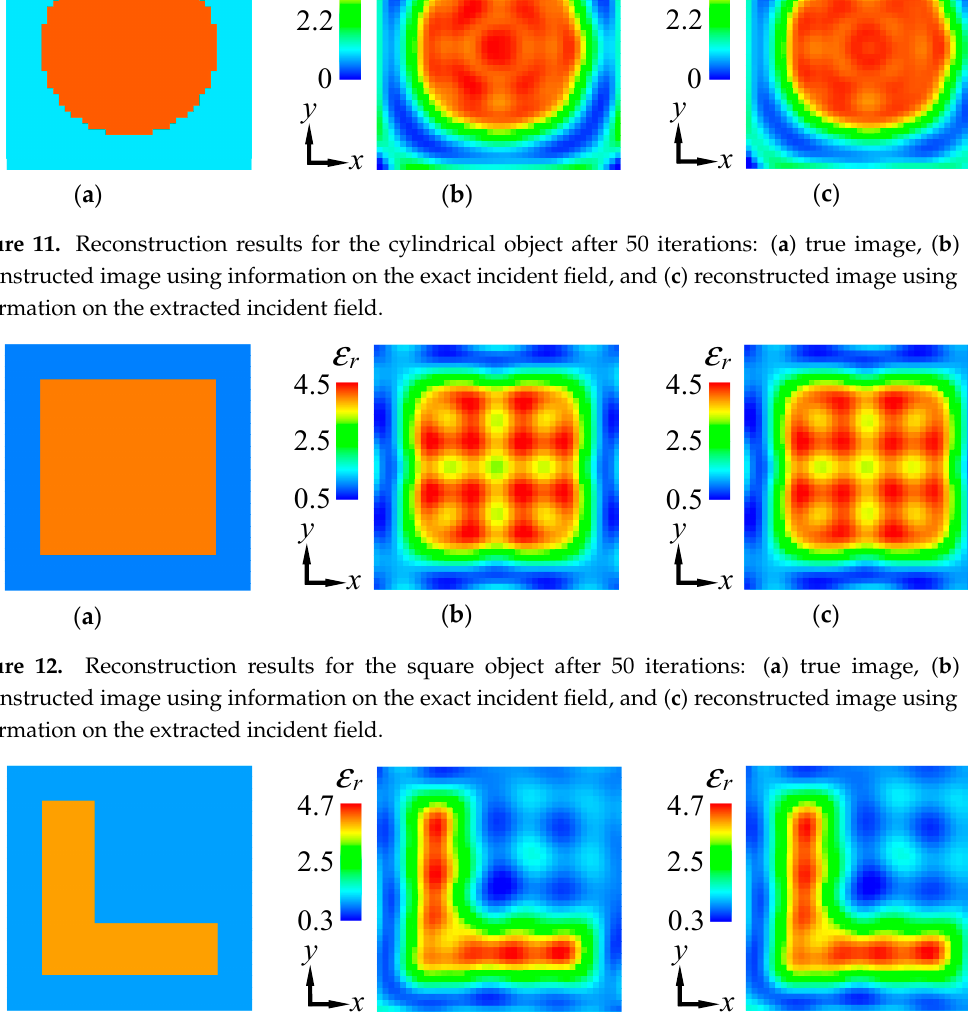
Figure 13. Reconstruction results for the L-shape object after 50 iterations: ( a ) true image, ( b ) reconstructed image using information on the exact incident field, and ( c ) reconstructed image using information on the extracted incident field.